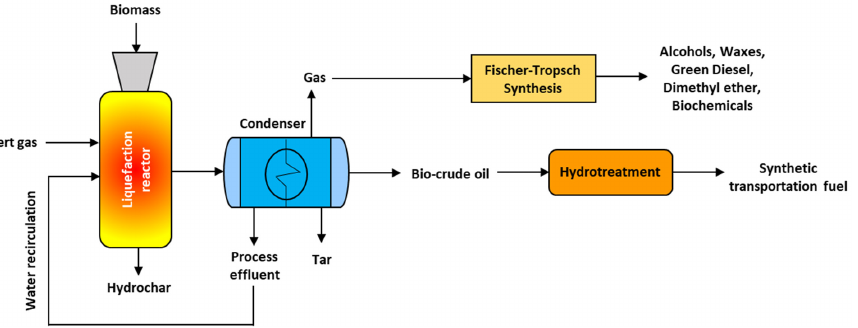
Figure 3. Typical process representation of liquefaction of biomass. Ethanol and subcritical water are some commonly used solvents in liquefaction. The role of solvents is critical in the dissolution of biomass by breaking hemicellulose, cellu-